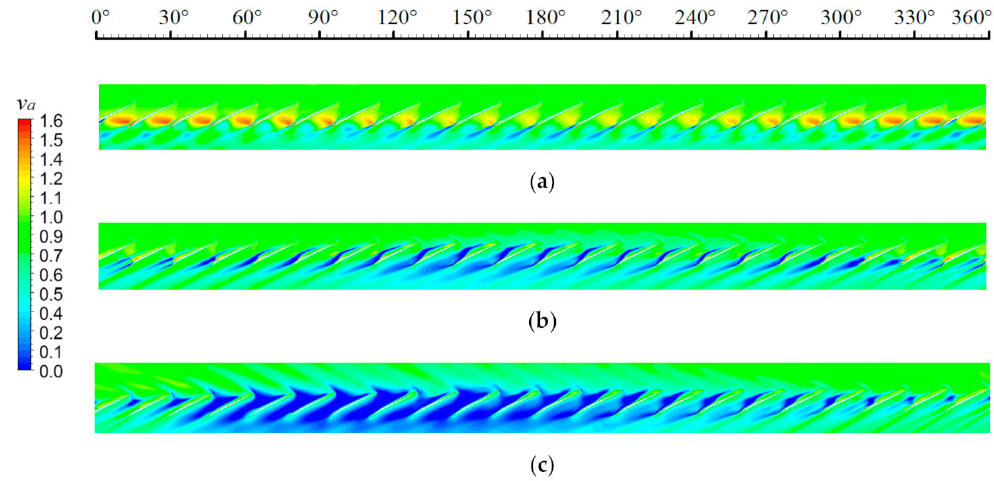
Figure 19. The circumferential distribution of the blade tip axial velocity coe ffi cient calculated by steady CFD under di ff erent working conditions at E = 160%. ( a ) NC; ( b ) NPE; ( c )